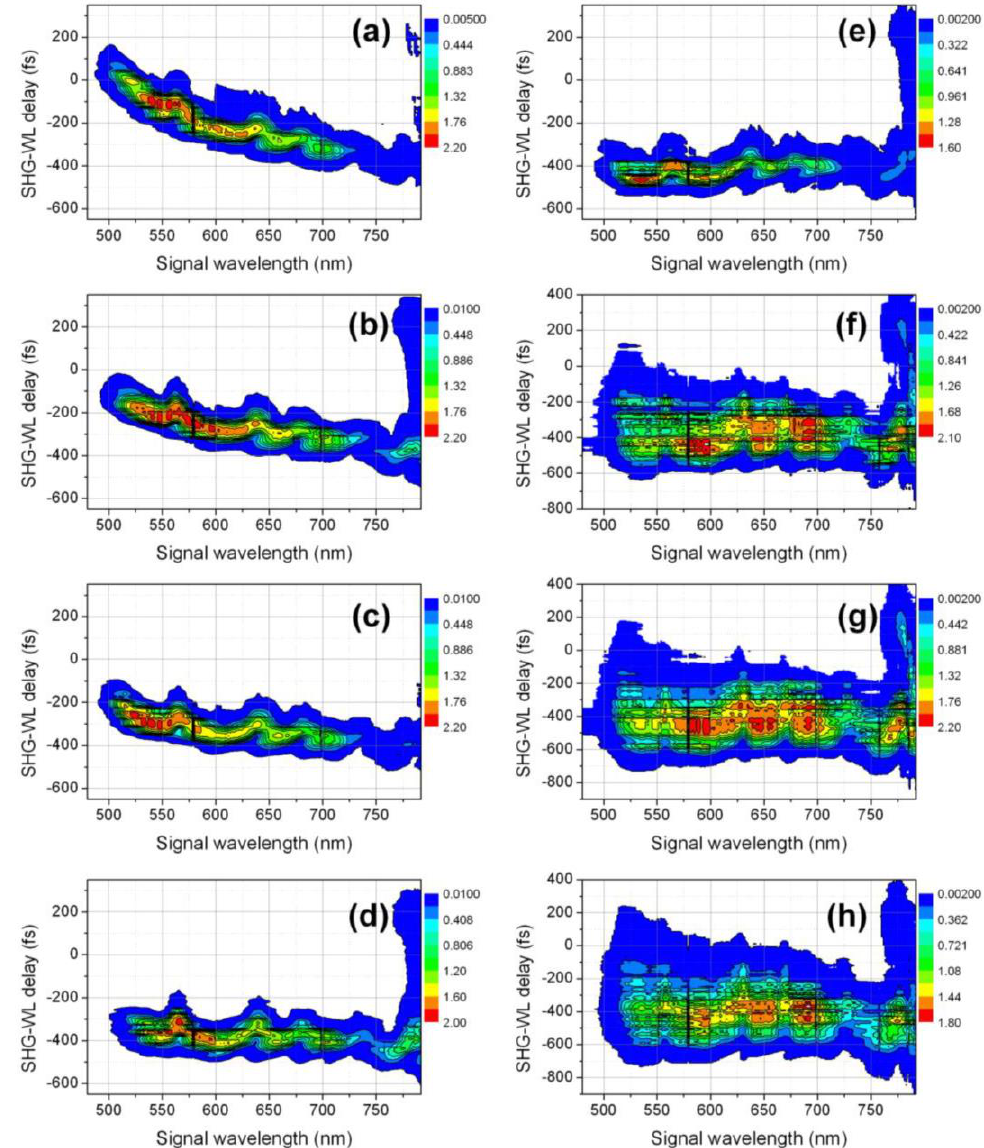
Figure 2. Two-dimensional plots of the pump-seed delay time dependence of the amplified signal spectra measured using a multichannel lock-in amplifier. ( a – h ) show the results for different experimental configurations, namely number of bounces at the chirped mirror in the white-light seed-compression system and across the length of the glass in the pump-pulse stretcher. Using (N, L) to denote the bouncing number (N) and glass length (L) in centimeters, ( a – h ) correspond to (0,0), (1,0), (2,0), (3,0), (4,0), (4,3), (4,4), and (4,5),